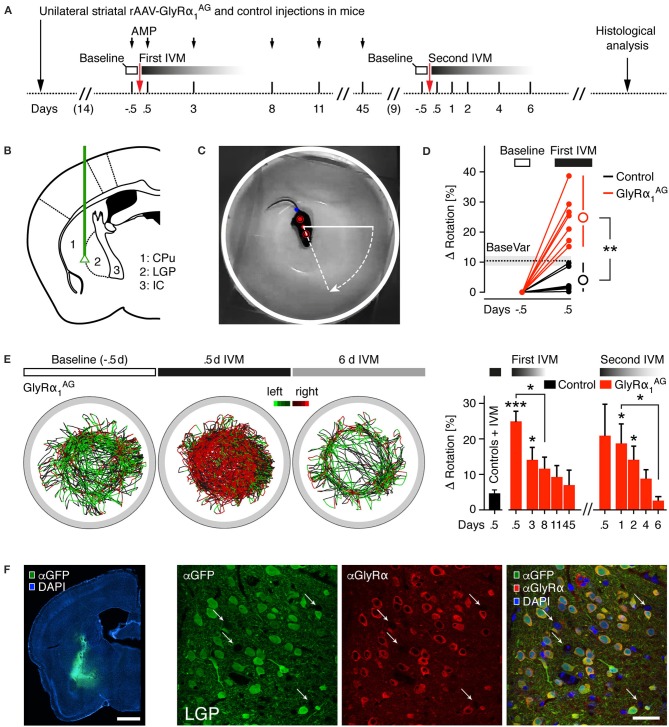
Unilateral expression of GlyRα1AG in the striatum of mice leads to a rotational phenotype after intraperitoneal IVM injection. (A) Time line of the experiment (AMP, amphetamine; IVM, ivermectin); injection time points of IVM are shown as arrows. (B) Injection sites; green line indicates path of injection cannula for unilateral striatal rAAV-syn-GlyRα1AG-2A-Venus and mock control (rAAV-syn-GlyRα1-2A-Venus and rAAV-syn-Venus) injections. Subregions depicted: CPu, caudate putamen; LGP, lateral globus pallidus; IC, internal capsule. (C) Camera picture and overlay showing the automatic extraction of three points on the mouse body (red dots) used to trace the rotation angle; tail point is marked in blue. (D) The baseline variability (BaseVar) of the rotational bias was quantified for all control mice on trials without preceding IVM injection; the i.p. injection of IVM led to a strong increase in rotational bias in all GlyRα1AG expressing mice 0.5 days after IVM exposure as compared to IVM treated, mock injected control animals; open circles indicate group averages (ΔRotation: Difference to baseline bias). (E) Left: Example trace diagrams of a mouse injected with rAAV-syn-GlyRα1AG-2A-Venus in the left hemisphere (45 min per trace), color coded for left (green) and right (red) turns; 0.5 days after IVM injection a strong bias to the right was found, which reversed after 6 days. Right: Time course of rotational bias after the first (2.5 mg/kg) and second (1.5 mg/kg) IVM injections in GlyRα1AG expressing mice; first bar on the left (black) shows all mock injected control mice 0.5 days after IVM injection (Controls + IVM, pooled first and second IVM injection); stars on top of bars indicate statistical significance vs. Controls + IVM (first bar on the left); 3.5 mg/kg AMP was injected i.p. 10 min before the recording started (First IVM). First IVM: GlyRα1AG
n = 7, Control n = 6; Second IVM: GlyRα1AG
n = 5; Control n = 5; data are shown as means ± SEM; *p < 0.05, **p < 0.01, ***p < 0.001. (F) Left: Representative image of a coronal brain section of a rAAV-syn-GlyRα1AG-2A-Venus injected mouse, immunostained for Venus (αGFP, green) and counterstained with DAPI (blue); scale bar 1 mm. Right: Maximum intensity projections of confocal microscopy images acquired in a brain slice in the injected region (LGP), immunostained for Venus (αGFP, green) and GlyRα1AG (αGlyRα, red), counterstained with DAPI (blue). Note GlyRα staining surrounding Venus expressing neurons; white arrows indicate putative uninfected neurons; scale bar: 40 μm.